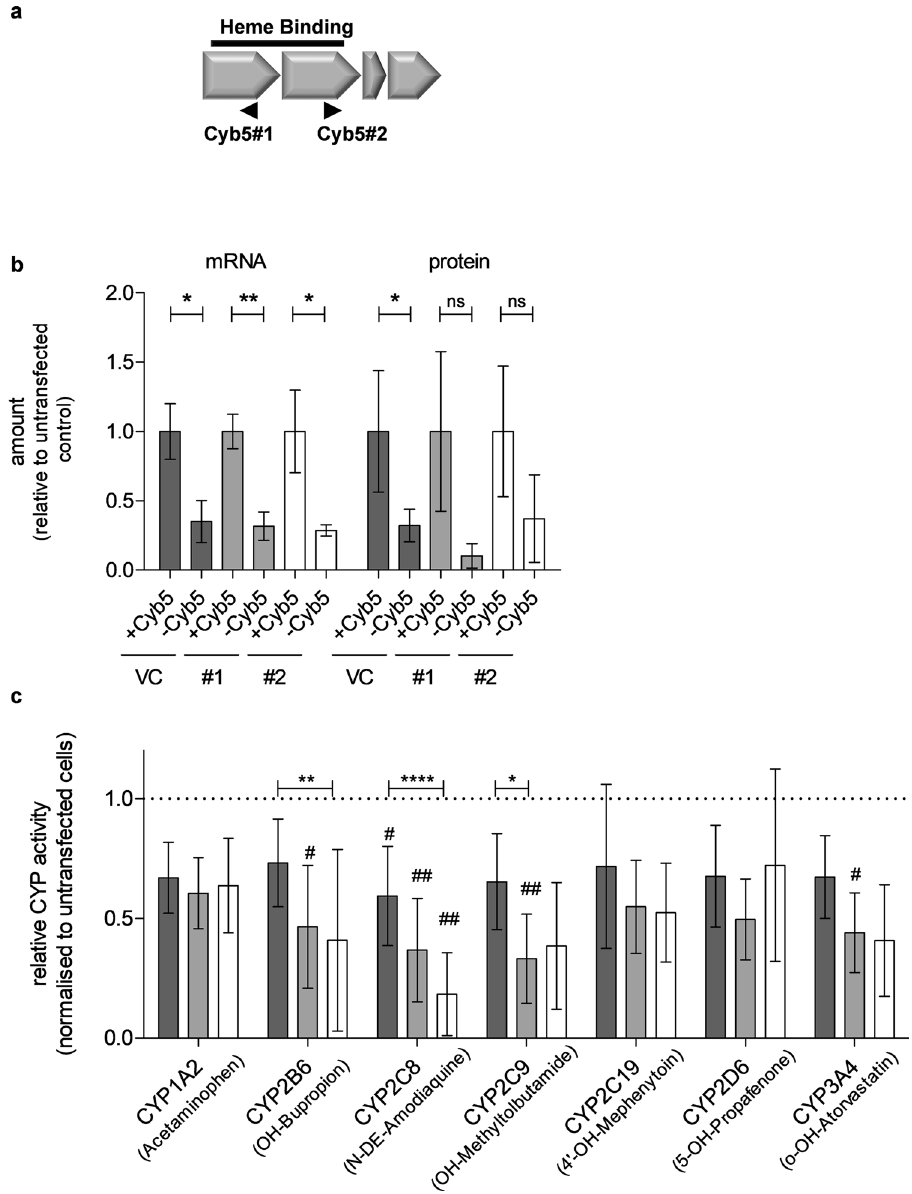
Figure 5. Genetic CYB5A and POR/CYB5A double-knockout in transduced HepaRG cells. ( a ) Location of CYB5A -targeting gRNAs relative to exon structure (gene chr18:74,250,846–74,292,016) indicating 4 translated exons as well as the binding region (black) for heme. The positions of two sgRNAs targeting exon 1 (CYB5#1) or exon 2 (CYB5#2) are indicated by arrows. ( b ) CYB5 mRNA and protein expression in transduced differentiated HepaRG cells quantified in cell lysates. Mean levels are shown relative to vector control (VC) set at 1 with SD bars (dark grey: VC, light grey: POR#1, white: POR#2). Results are means ± SD of three independent experiments. Statistical significance was assessed by unpaired t-test ( c ) Enzyme activities of seven CYP enzymes were determined simultaneously by cocktail LC–MS/MS assay in VC (dark grey), sgRNA POR#1 (light grey) and POR#2 (white) cells. Results are means ± SD of three independent experiments. Statistical significance was assessed by repeated measurements ANOVA with Bonferroni correction (* p < 0.05, ** p < 0.01, *** p < 0.001, **** p <